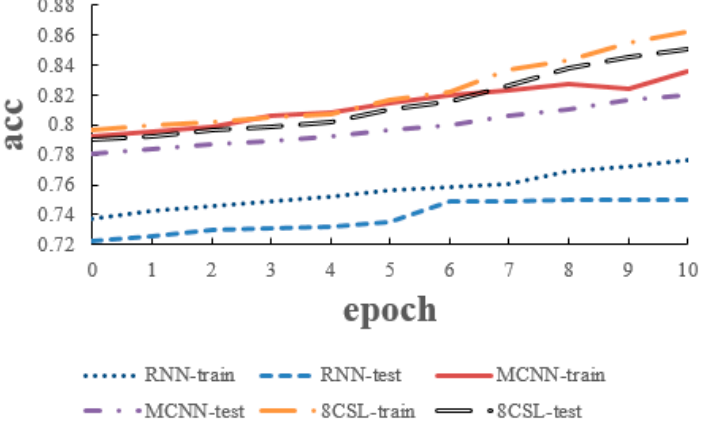
Figure 13. Accuracy curves of the three models on the 10 second data.